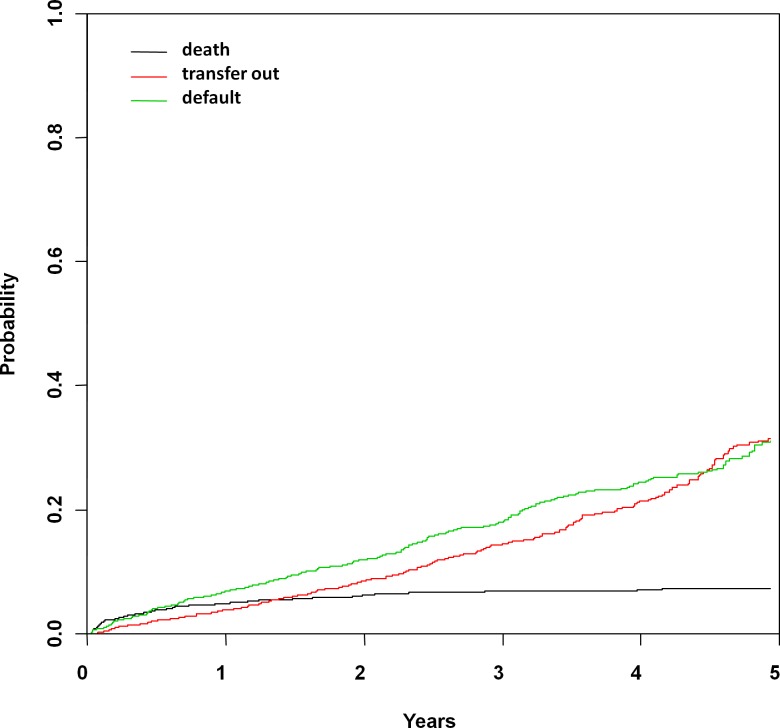
Estimated cumulative incidence curves with mortality, transfer out of cohort, and default as competing events.